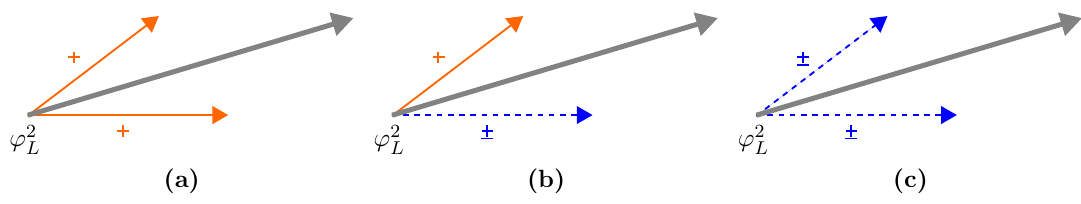
Figure 2. Di(cid:11)erent processes contributing to the spectral density. In all (cid:12)gures, the short dashed arrow is the momentum of a background excitation, the short solid arrow is the momentum of an external excitation, and the long arrow is the sum of the two. A plus sign represents a positive energy excitation whereas a minus sign represents energy absorption from the background. The process depicted in the (cid:12)nal panel does not contribute in thermal